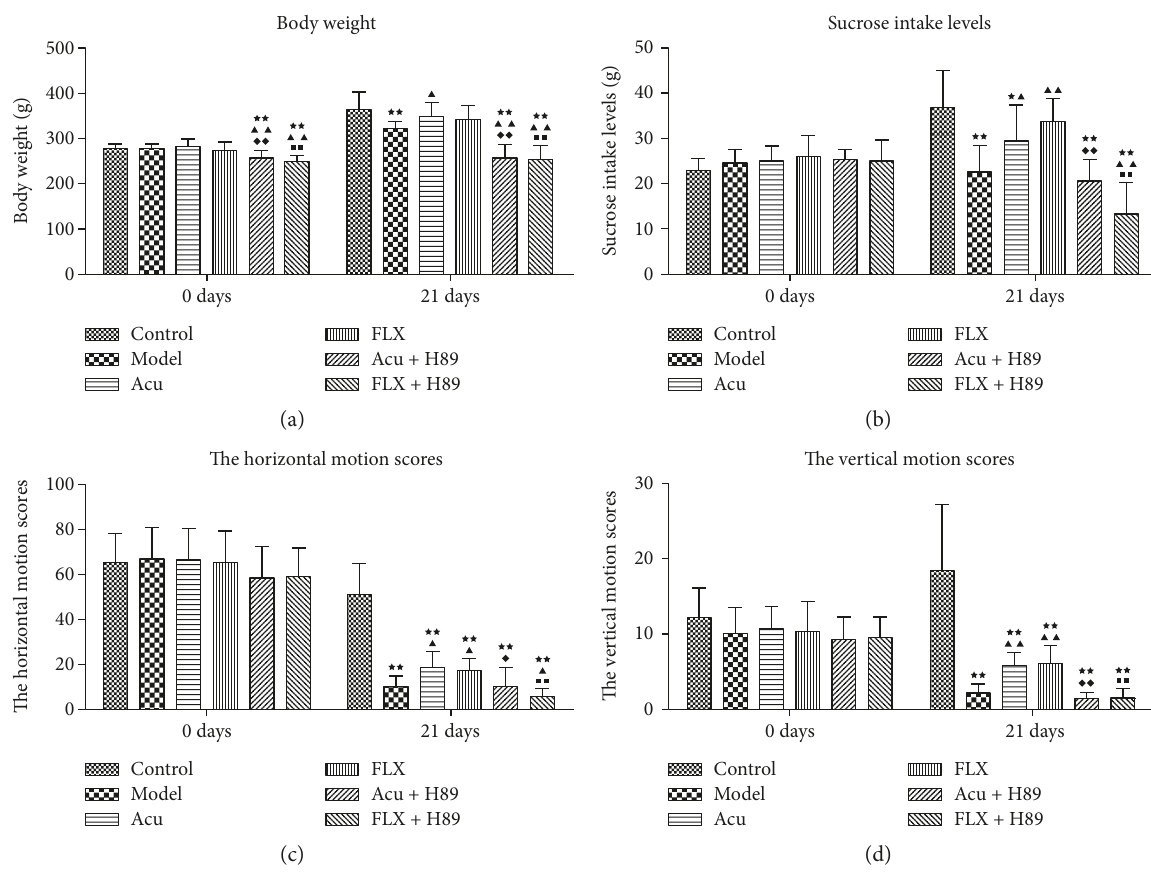
Figure 2: Di ff erences showing the e ff ects of stress/ antidepressant treatments on depressive-like behaviors in depression rats induced by CUMS. (a) The e ff ects of stress/antidepressant treatments on the body weight in depression rats induced by CUMS. (b) The e ff ects of stress/antidepressant treatments on the sucrose intake levels in depression rats induced by CUMS. (c) The e ff ects of stress/antidepressant treatments on the horizontal motion scores in depression rats induced by CUMS. (d) The e ff ects of stress/antidepressant treatments on the vertical motion scores in depression rats induced by CUMS. Di ff erences are shown as follows: ★ P < 0 05 versus control group; ★★ P < 0 01 versus control group; ▲ P < 0 05 versus model group; ▲▲ P < 0 05 versus model group; ◆ P < 0 05 versus acupuncture group; ◆◆ P < 0 01 versus acupuncture group; ■■ P < 0 01 versus fl uoxetine group. Values are given as x ± s for 10 rats in each group. Acu: acupuncture group; FLX: fuoxetine group; Acu +H89: Acupuncture +H89 group; FLX +H89: Fluoxetine+H89